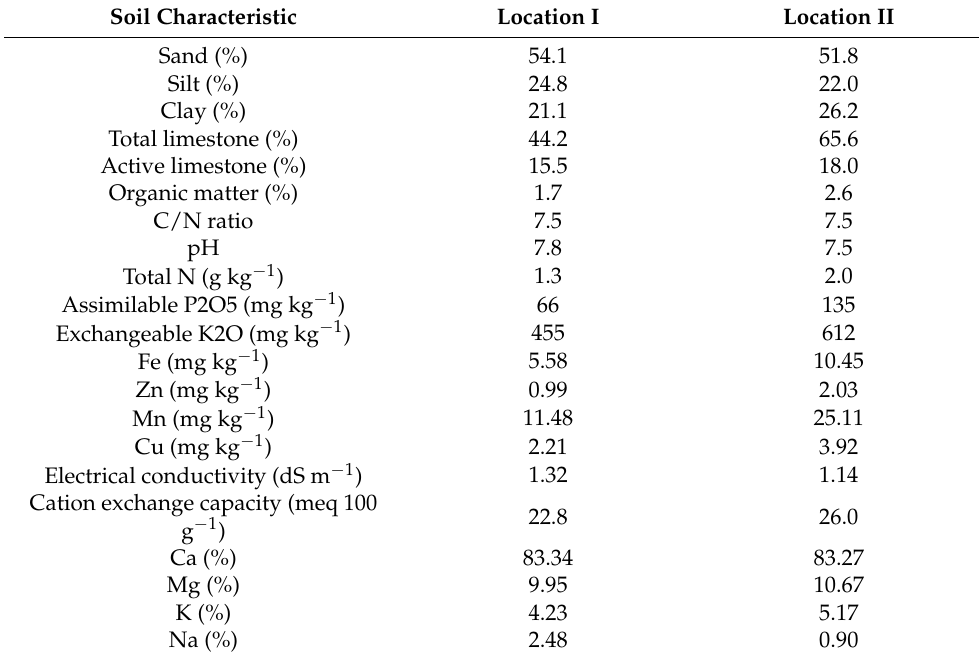
Table 1. Soil physical and chemical characteristics (from − 0.05 to − 0.30 m depth) of the two locations under study. Soil